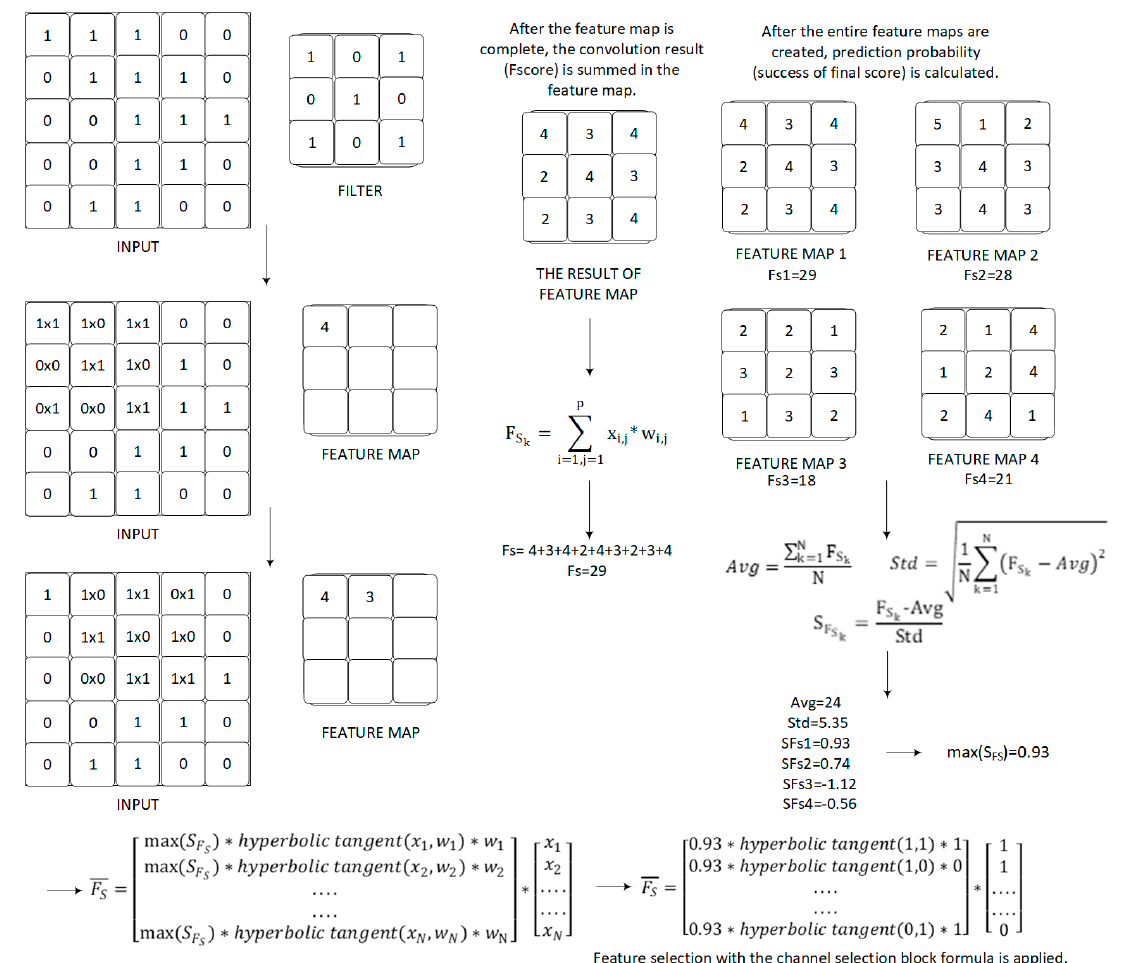
Figure 3. Specific example of prediction probability calculation with the formulas.